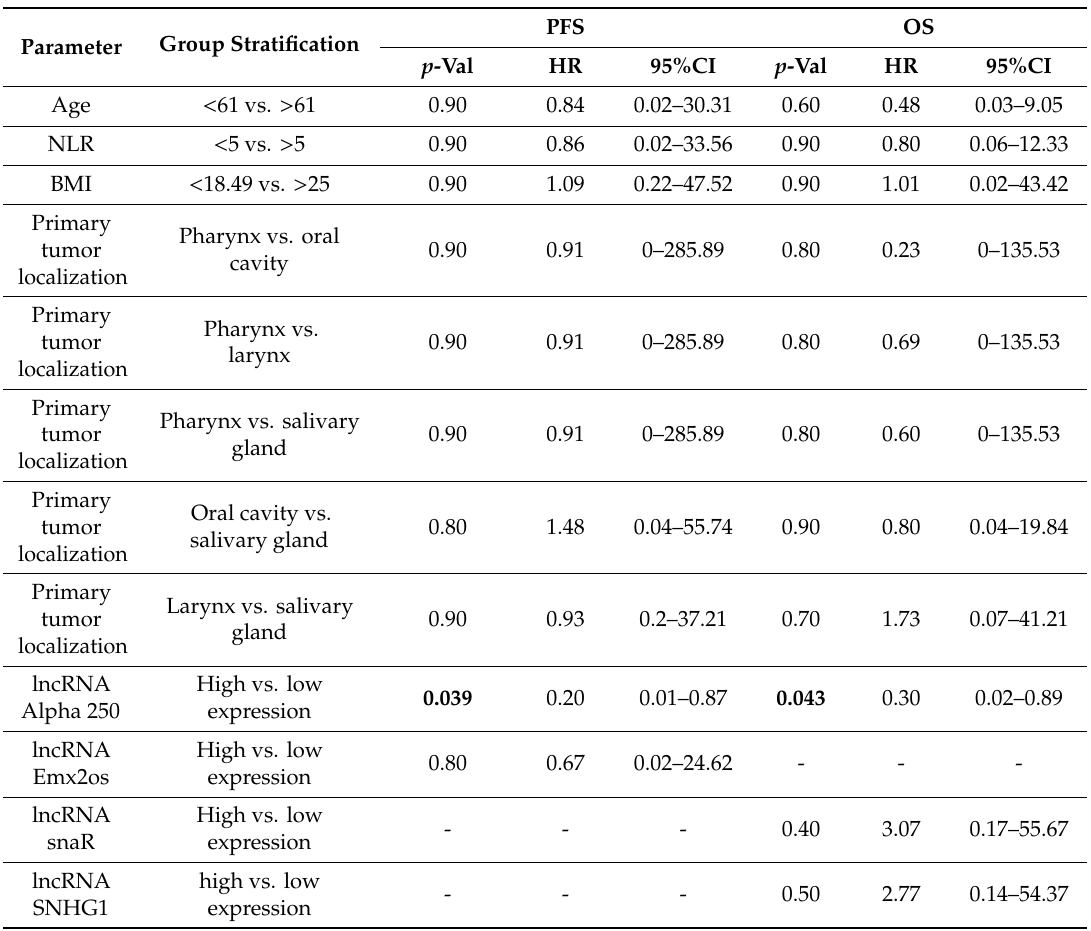
Table 2. Multivariate Cox regression model for PFS and OS. PFS—progression free survival;